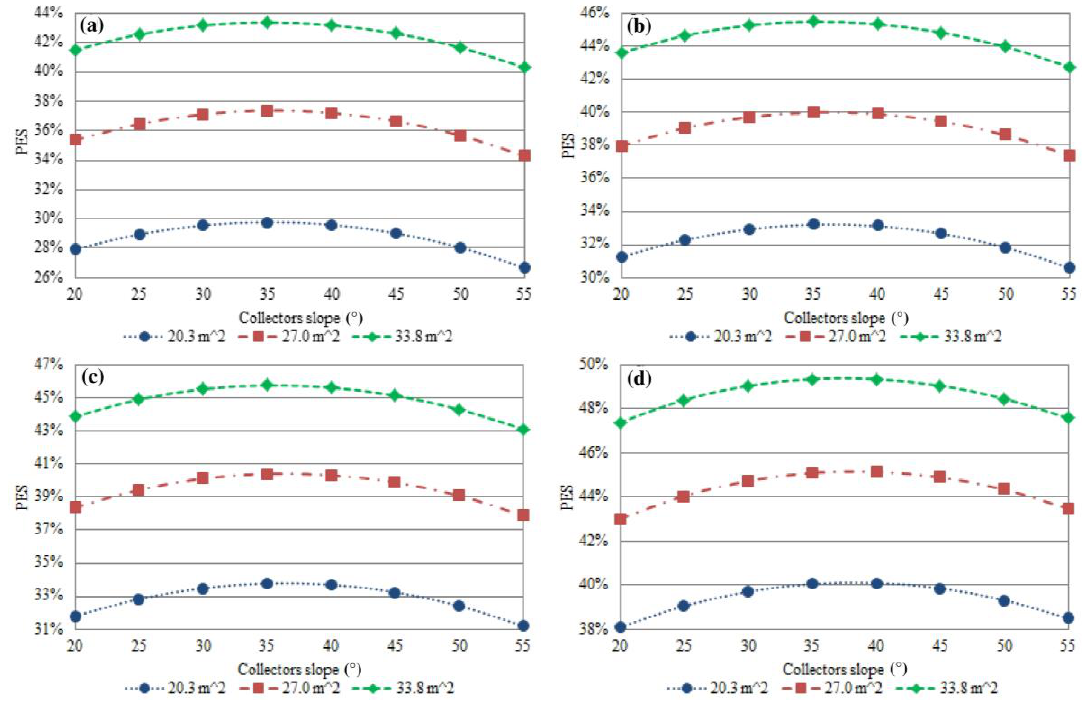
Figure 10. Primary energy saving of the ASs with 50% of solar thermal energy surplus used and flat-plate collectors in the four alternative configurations: ( a ) Scenario A; ( b ) Scenario B; ( c ) Scenario C; and ( d ) Scenario D. Energies 2016 , 9 , 724